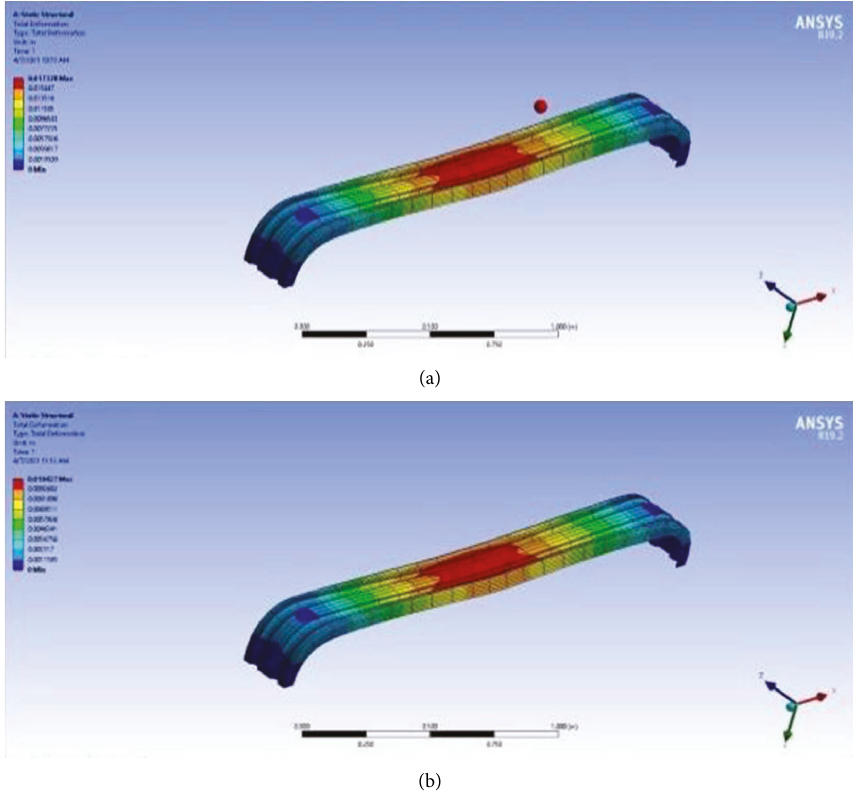
Figure 7: Total deformation of (a) basalt fibre bumper and (b) basalt aluminium fibre.